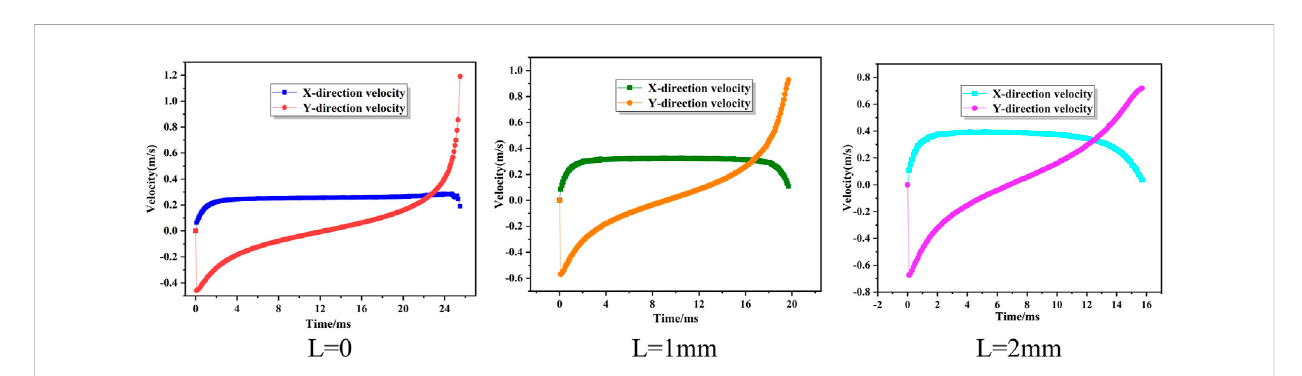
FIGURE 13 Velocity of carbon particles at different carbon trace